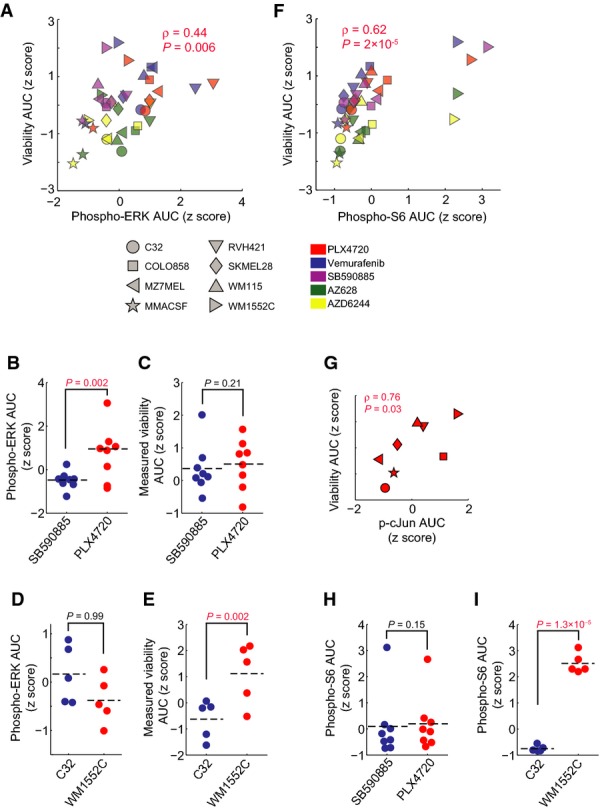
A multifactorial adaptive response, rather than initial target inhibition, determines melanoma response to RAF inhibitors

Pairwise Spearman's correlation between the 1-h changes in pERK(Thr202/Tyr204) levels as measured by immunofluorescence microscopy and 72-h relative viability both represented by the z-score-scaled AUC of the seven dose–response curves for four RAF inhibitors and one MEK inhibitor across 8/10 cell lines investigated in this study.

Comparison of the level of 1-h pERK inhibition for 8 cell lines treated with SB590885 versus PLX4720.

Comparison of the 72-h measured relative viability AUC for 8/10 cell lines treated with SB590885 versus PLX4720.

Comparison of the level of 1-h pERK inhibition between two cell lines (C32 and WM1552C) treated with four RAF inhibitors and one MEK inhibitor.

Comparison of the 72-h measured relative viability AUC between two cell lines (C32 and WM1552C) treated with four RAF inhibitors and one MEK inhibitor.

Pairwise Spearman's correlation between the 24-h changes in pS6(Ser235/236) levels as measured by immunofluorescence microscopy and 72-h relative viability both represented by the z-score-scaled AUC of the dose–response curves for four RAF inhibitors and one MEK inhibitor across 8/10 cell lines investigated in this study.

Pairwise Spearman's correlation between the 24-h p-cJun levels as measured by immunofluorescence microscopy and 72-h relative viability after treatment with PLX4720 for 8 cell lines. p-cJun levels are averaged over five doses (0.1–5 μM), and viability is represented by the AUC of the dose–response curves.

Comparison of the level of 24-h pS6 inhibition for 8 cell lines treated with SB590885 versus PLX4720.

Comparison of the level of 24-h pS6 inhibition between two cell lines (C32 and WM1552C) treated with four RAF inhibitors and one MEK inhibitor.

Data information: P-values in (B–E, H, I) were calculated using one-tailed paired Student's t-test. Source data are available online for this figure.